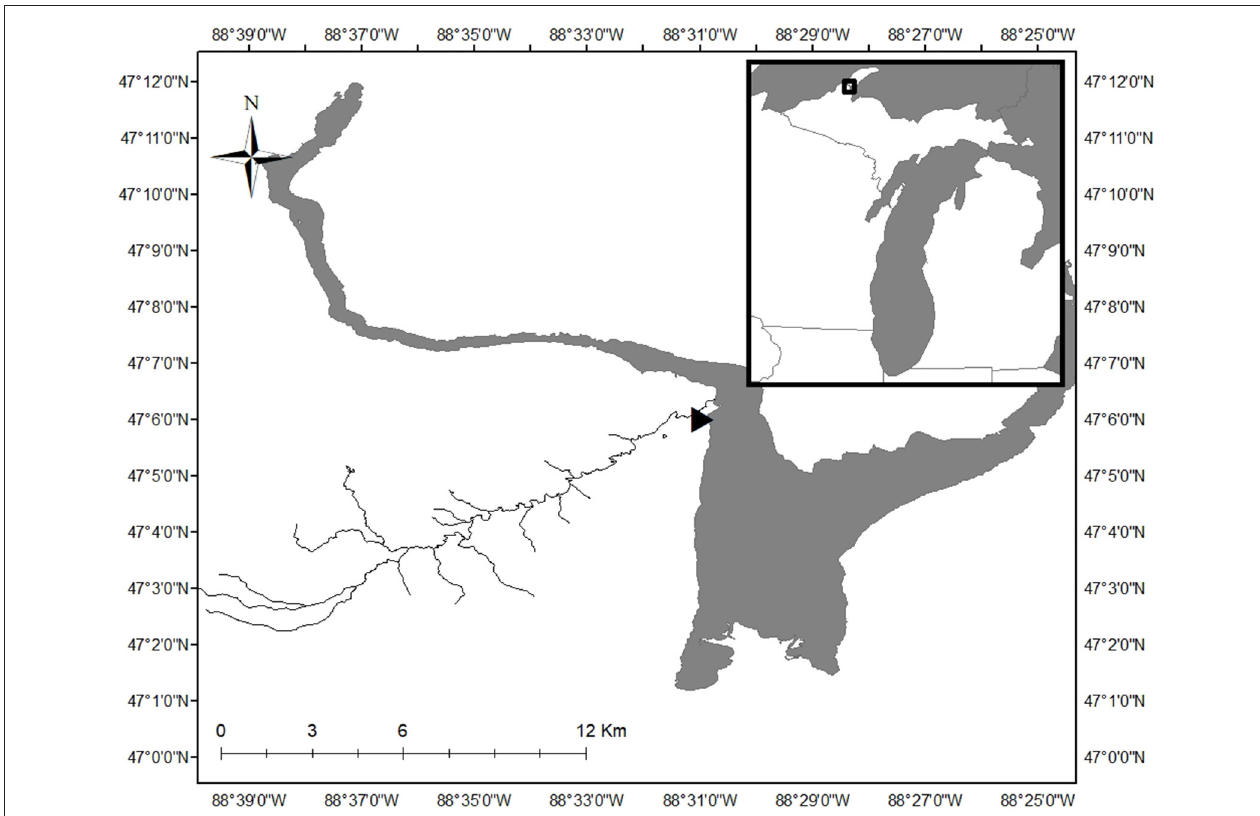
FIGURE 1 | The 20-m long study reach (location indicated by triangle) was located on the Pilgrim River on the Upper Peninsula of Michigan, USA. The inset shows the location of the study area within the state of Michigan. Map of Pilgrim River derived from Hydrography Lines_(v17a) shapefile from State of Michigan GIS Open data